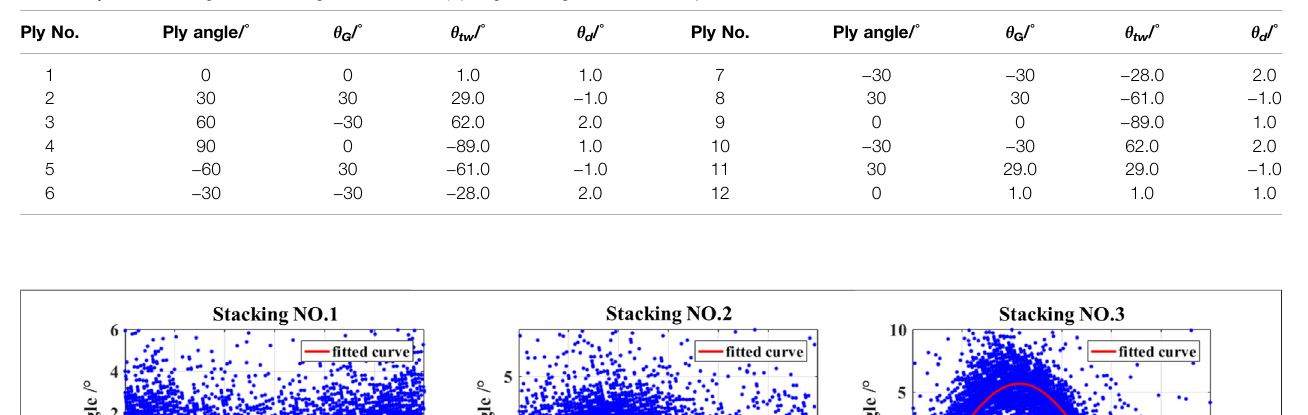
Frontiers in Mechanical Engineering |